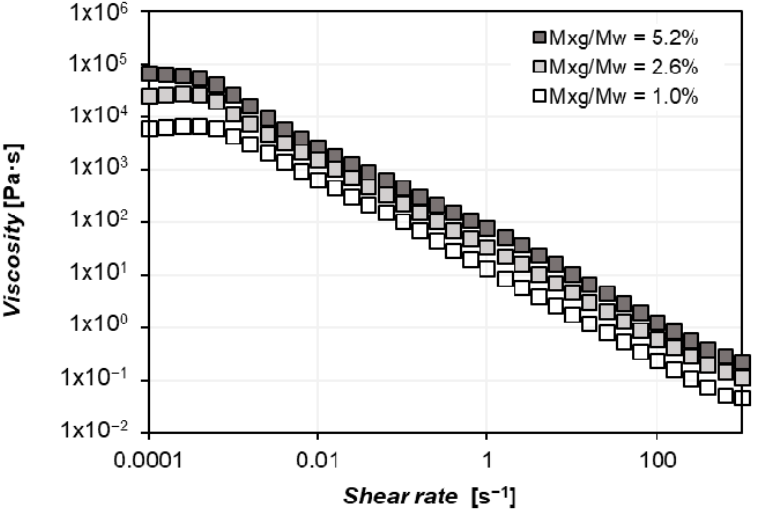
Figure 2. Shear rate dependent viscosity reduction of xanthan gum hydrogels at different xanthan gum to water ( M xg / M w ) ratios in